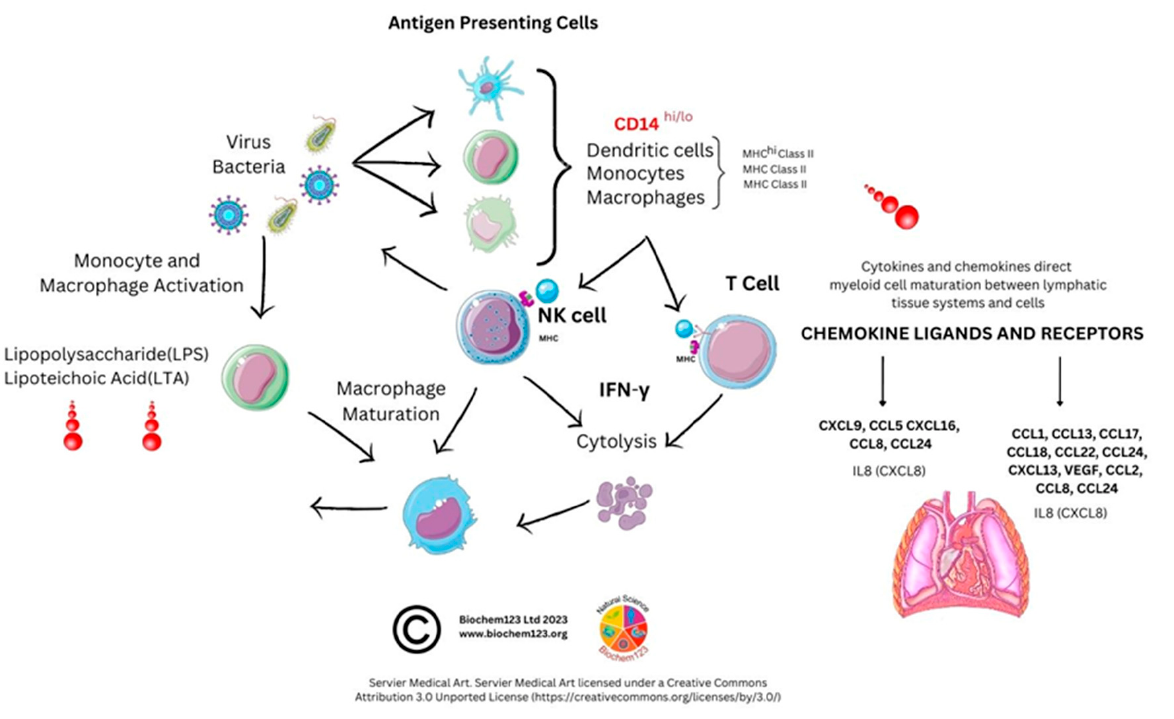
Figure 4. Antigen presenting cell roles in SARS-CoV-2 infection.